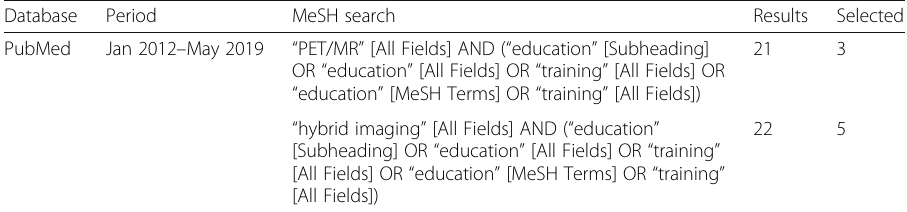
Table 1 Search strategy used for the literature review